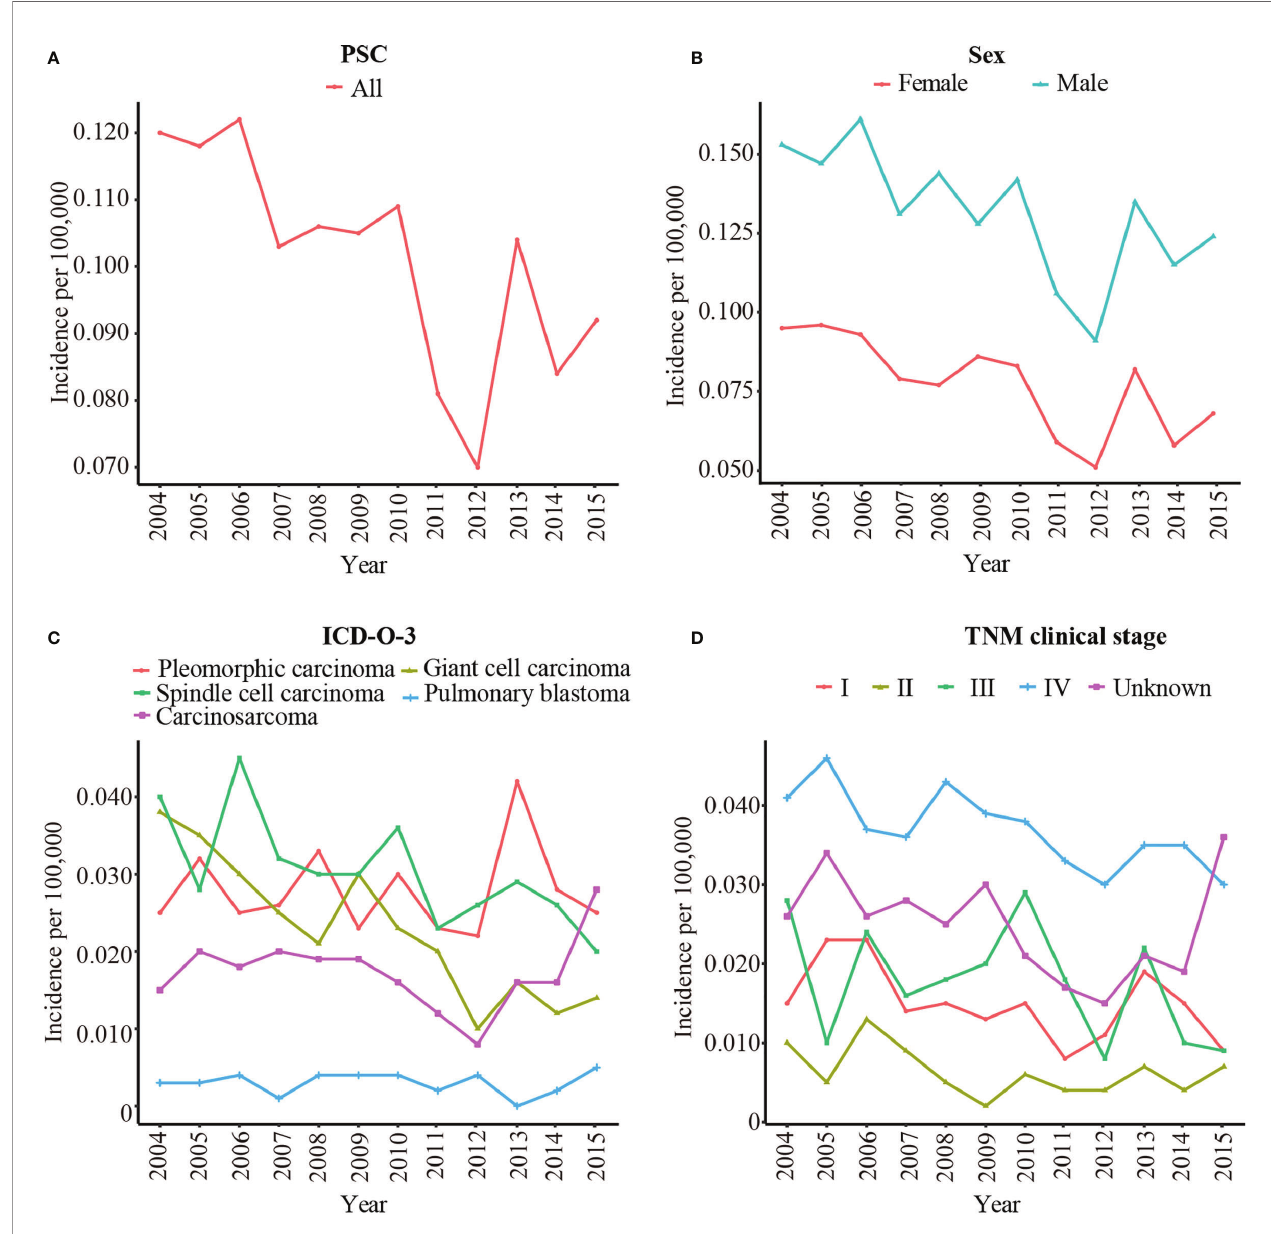
FIGURE 2 | The age-adjusted incidence of PSC from 2004 to 2015 by sex, pathological type, and TNM clinical stage. (A) The age-adjusted incidence of all patients with PSC; (B) The age-adjusted incidence of PSC by sex; (C) The age-adjusted incidence of PSC by pathological type; (D) The age-adjusted incidence of PSC by TNM clinical stage. PSC, pulmonary sarcomatoid carcinoma; TNM clinical stage, tumor – node – metastasis clinical stage; ICD-O-3, International Classi fi cation of Disease for Oncology, 3 rd